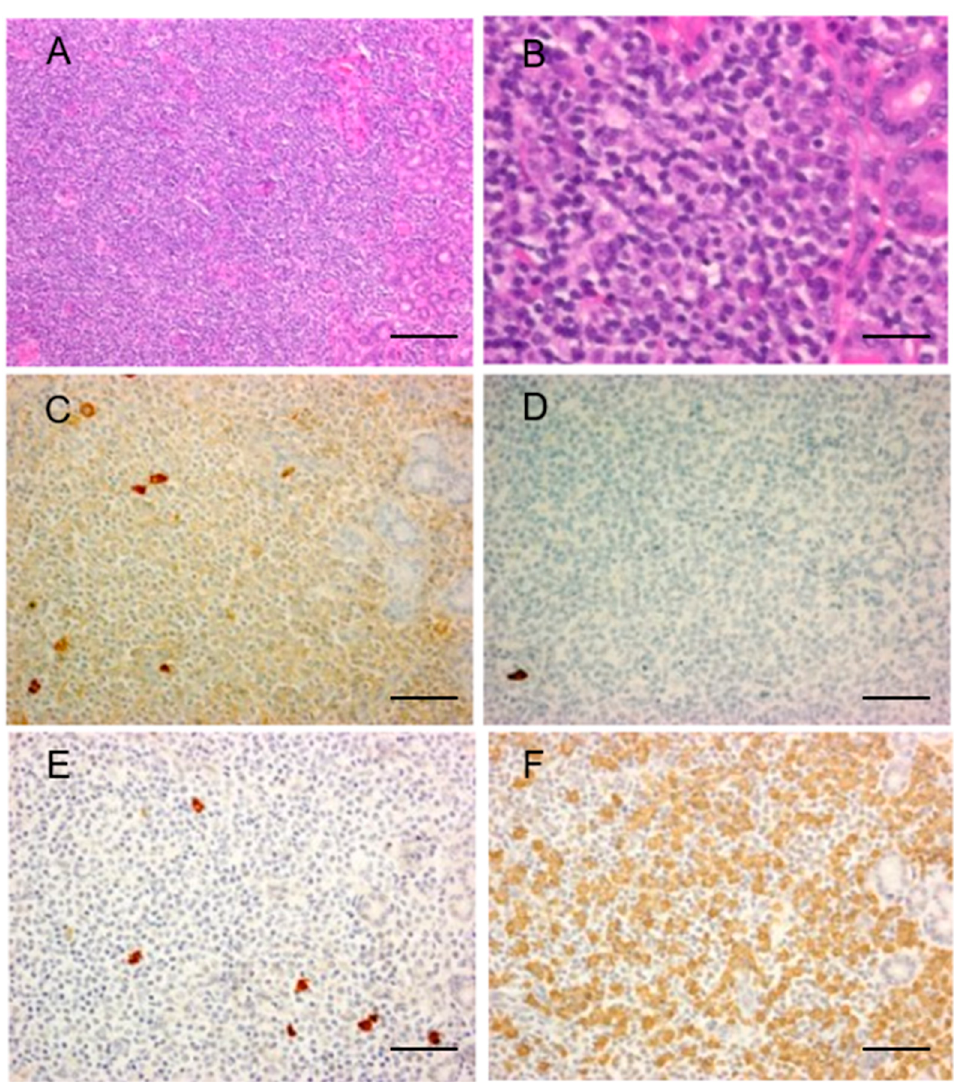
Figure 3. Marginal zone lymphoma without IgG4-positive cells. Representative pathological images of marginal zone lymphoma without IgG4-positive cells. Interfollicular expansion and diffuse proliferation of medium-sized atypical lymphoid cells ( A , B ). Low number of IgG+ ( C ) and IgG4+ ( D ) cells are present and the IgG4+/IgG+ cell ratio is <40%. A few Ig κ + B cells are present ( E ). Numerous Ig λ + B cells with light chain restriction were noted ( F ). Scale bar; ( A ): 200µm, ( B ): 50 µm, ( C – F ): 100 µm.